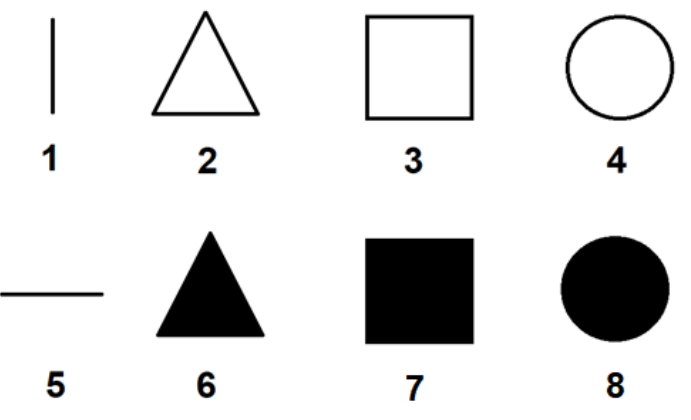
Figure 21. 2D training patterns.